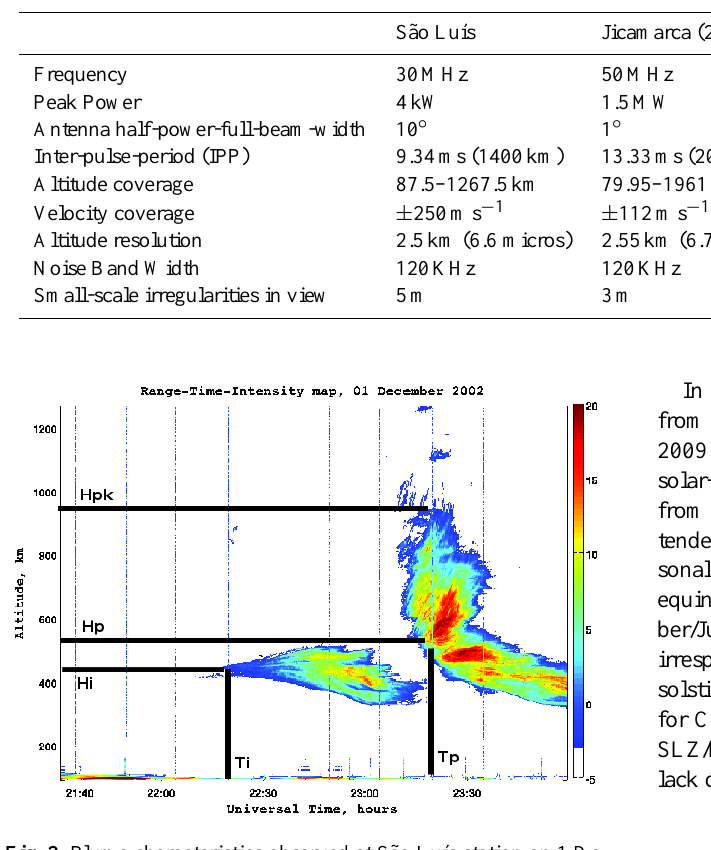
Fig. 2. Plume characteristics observed at São Luís station on 1 De- cember 2002. The VHF radar parameters are highlighted in black labels, where T i and T p parameters mean the onset time of the bottom-type and the plume, respectively. The H i , H p and H pk pa- rameters mean the onset altitude of the bottom-type, onset altitude of the plume and peak altitude of the plume,